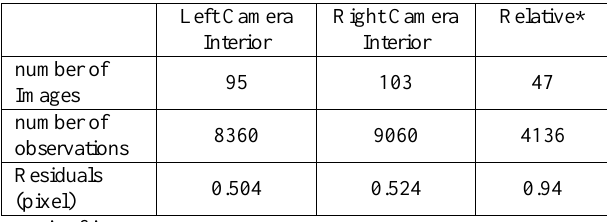
Table 1: Interior and relative orientation results.